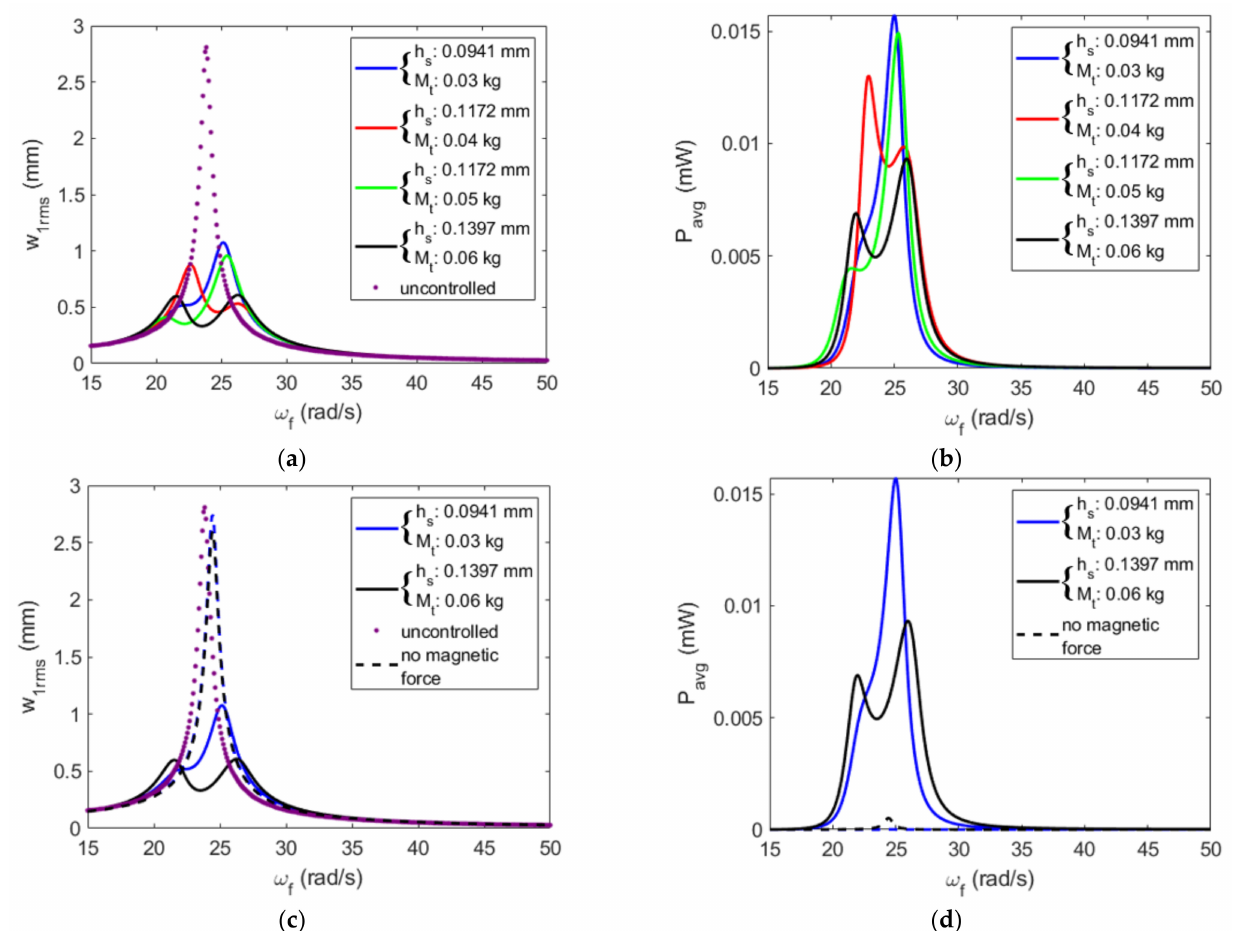
Figure 26. The effects of paired substrate thicknesses and tip masses that induce strong coupling and an initial gap of 5 mm on the amplitude of the ( a ) primary structure and ( b ) absorber, as well as a comparison with configurations with no magnets ( c , d ).